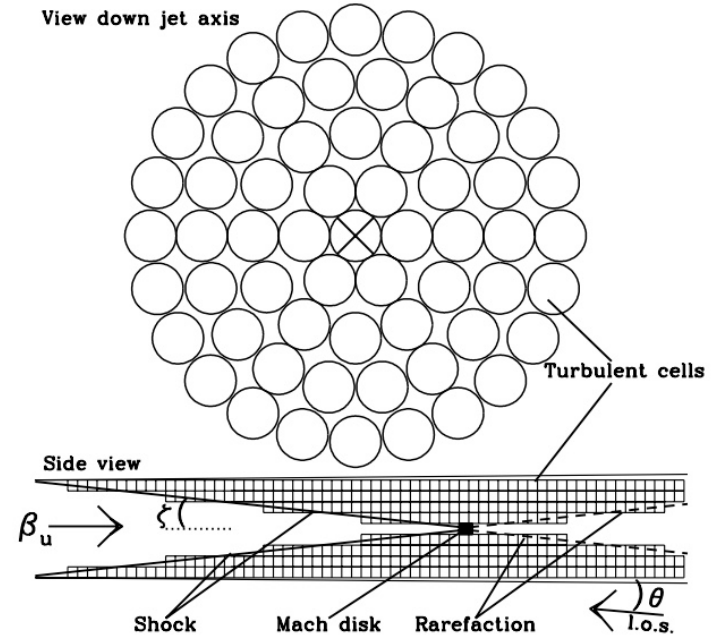
Figure 6. A cartoon of the model considered in [26]. Plasma flowing in the jet encounters an oblique shock, where particle acceleration occurs through DSA. In the downstream region the flow is assumed to be highly turbulent and it is modeled by assuming cells in which the physical parameters (in particular, the magnetic field orientation and maximum energy of the electrons) can assume different values. From [26]. Reproduced by permission of the